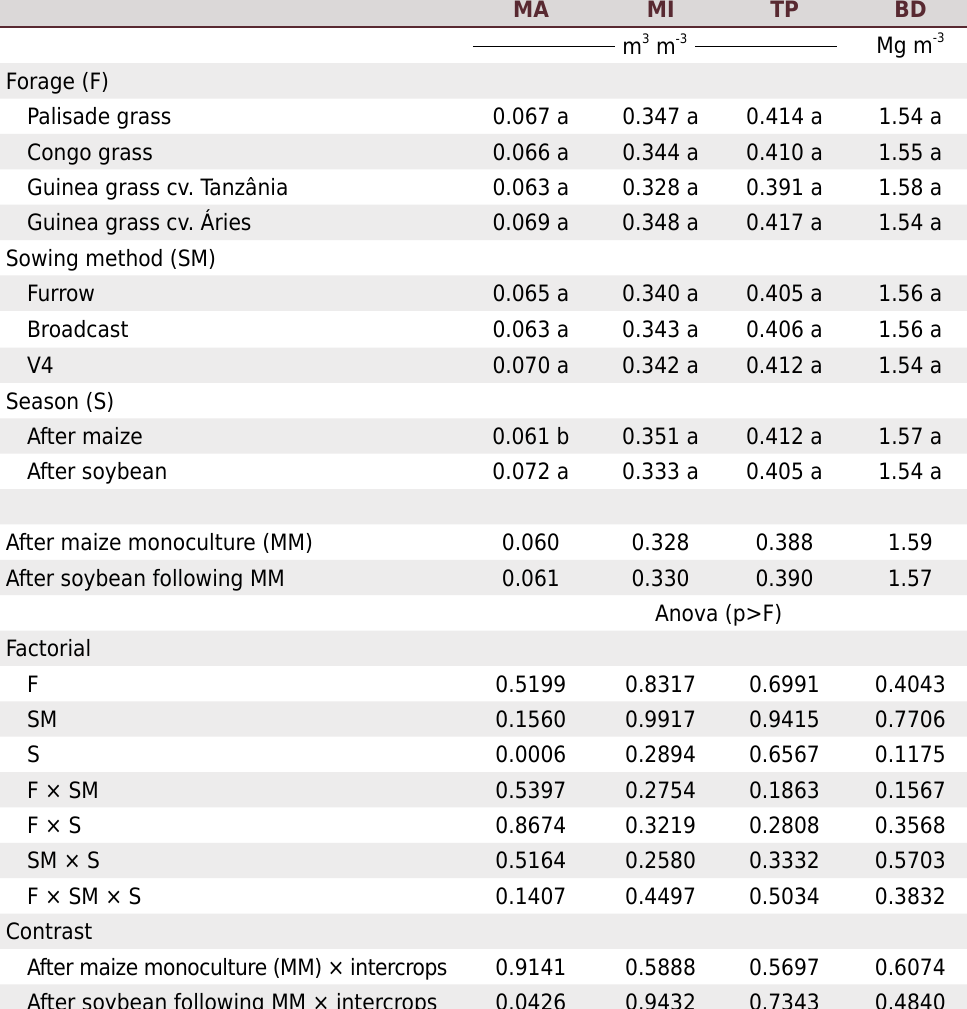
Table 6. Macroporosity (MA), microporosity (MI), total porosity (TP) and soil density (BD) in the 0.0-0.2 m layer, after harvest of maize in monoculture or intercropped with forages sown in different methods and after harvest of subsequent soybean and significance of ANOVA in factorial and contrast